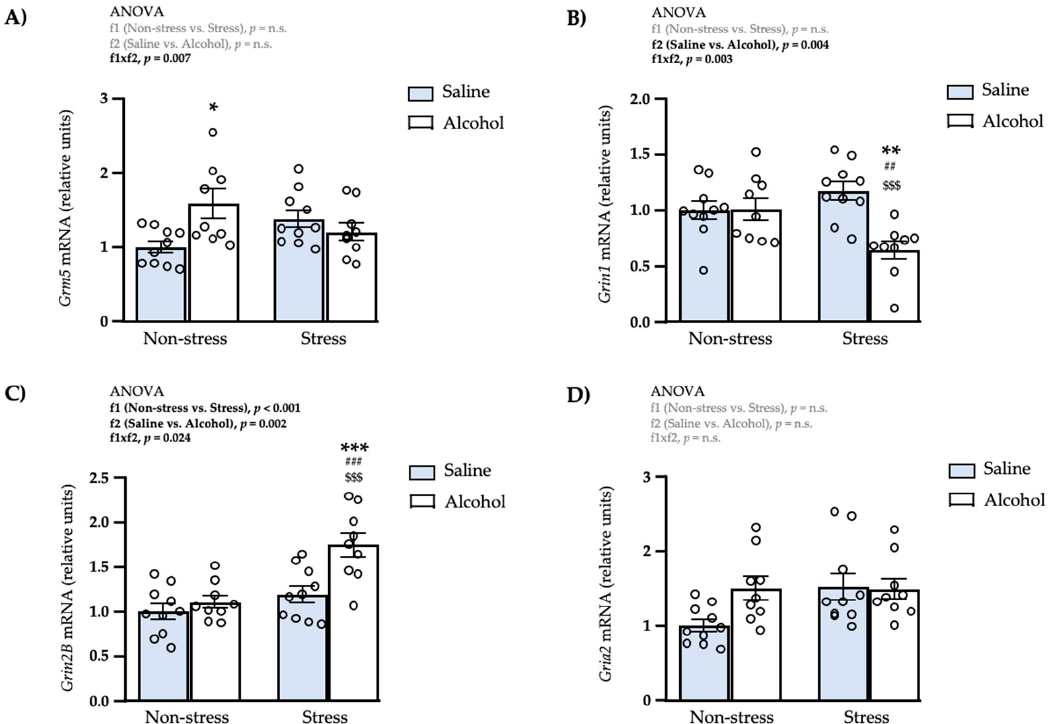
Figure 5. Relative mRNA expression levels of glutamatergic receptor subunits in the amygdala of adult male rats after repeated restraint stress and/or intermittent alcohol exposure during adolescence. Relative mRNA expression of Grm5 ( A ); Grin1 ( B ); Grin2B ( C ); and Gria2 ( D ) in male adult rats after repeated restraint stress (f1) and/or intermittent alcohol exposure (f2) during adolescence. Bars represent the mean ± SEM (9–10 rats/subgroup). Data were analyzed by two-way ANOVA. (*) q < 0.05, (**) q < 0.01 and (***) q < 0.001 denote significant differences compared with the non-stress saline subgroup, ( $$$ ) q < 0.001 denotes significant differences compared with the stress saline subgroup, and ( ## ) q < 0.01 and ( ### ) q < 0.001 denote significant differences with the non-stress alcohol subgroup using post hoc tests for multiple comparisons when an interaction between factors is found (f1 × f2). p -values in bold denote significant main effects of factors (f1 and f2) or significant interaction (f1 × f2).